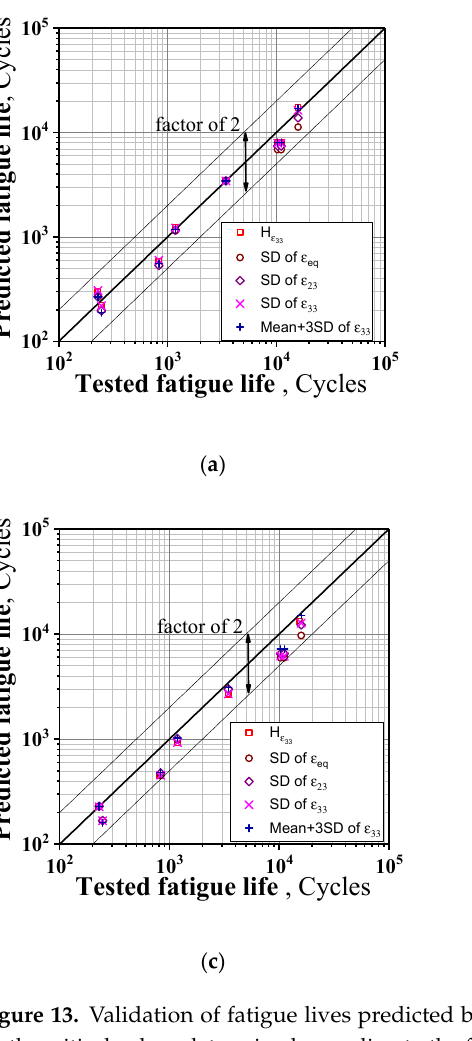
Figure 13. Validation of fatigue lives predicted by applying FIPs ( a ) the critical values determined according to the fatigue test at the strain amplitude cycle of 0.00601; ( b ) the upper prediction; ( c ) the lower prediction.